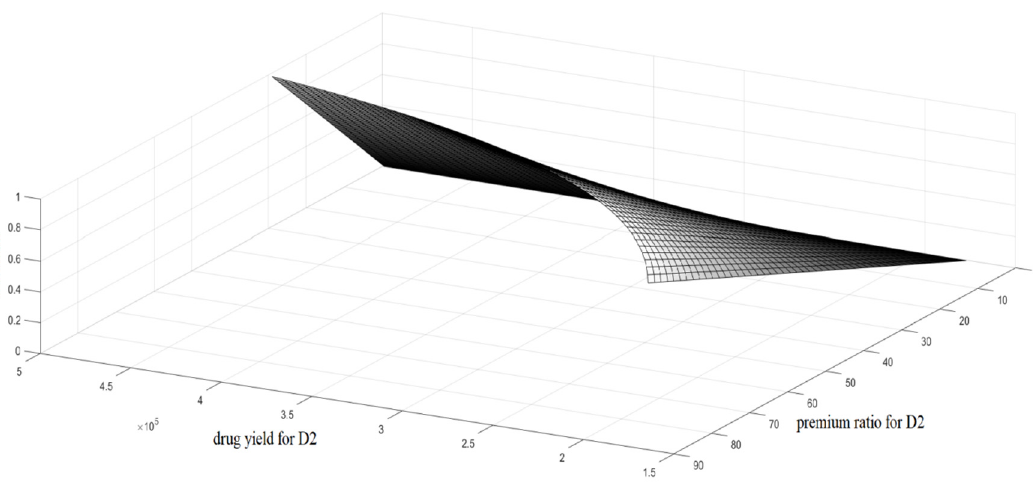
Figure 3. Relationships among tax rate and drug yield of D2, and the premium ratio of D2.